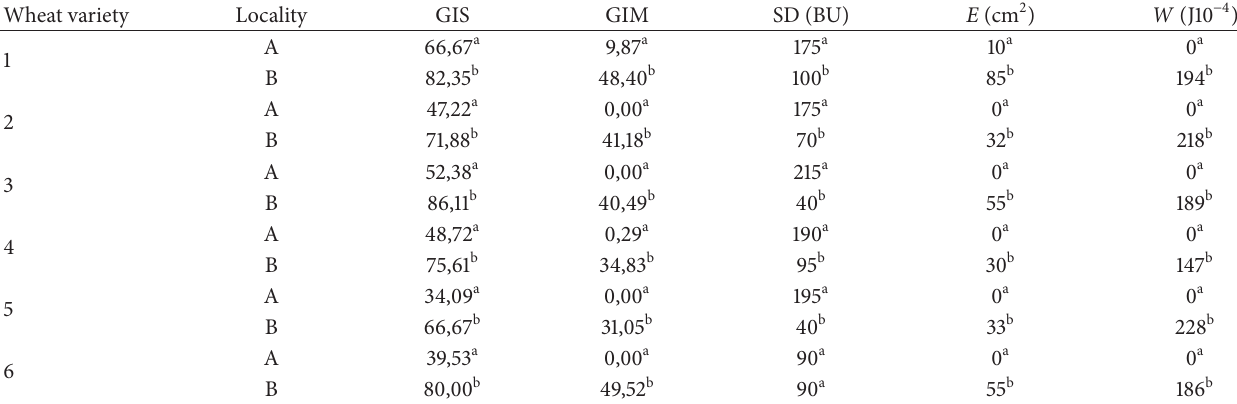
Table 1: Comparison of technological quality of wheat varieties between selected localities. Wheat variety